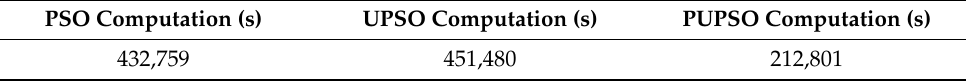
Table 12. Comparison of computational time with three computing